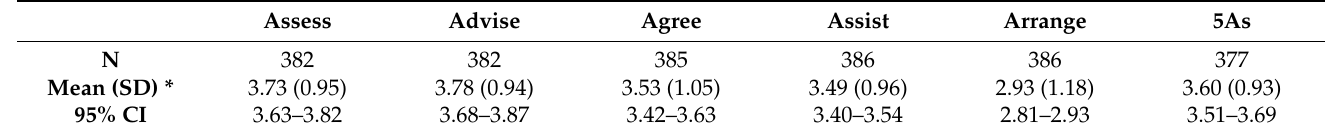
Table 2. Overall results of the PACIC+